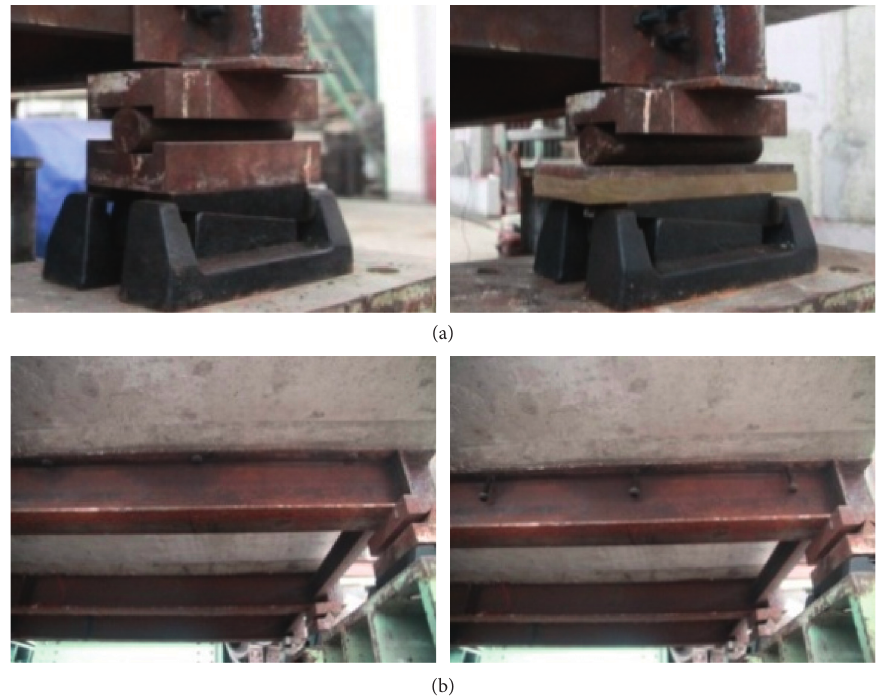
Figure 3: Two defect cases in the service condition: (a) Case 1; (b) Case 2.